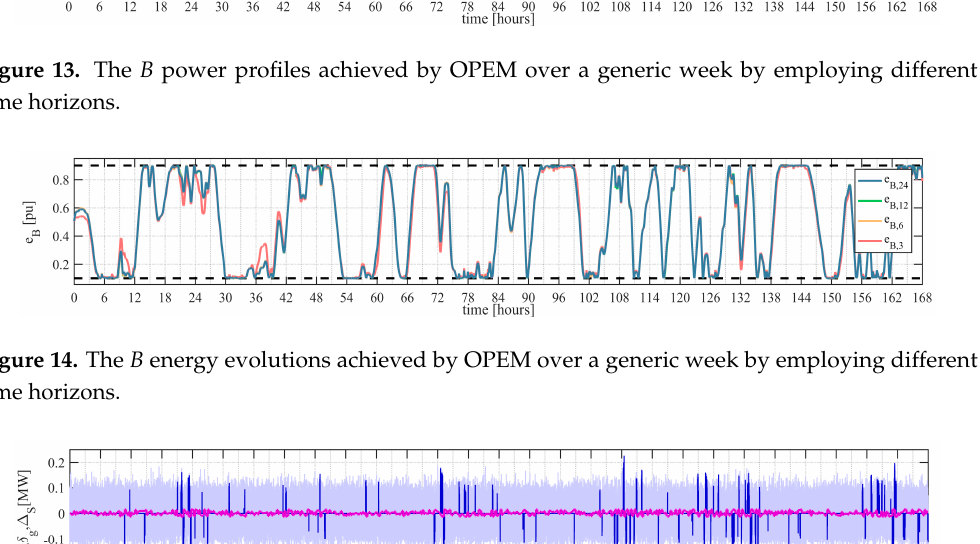
Figure 15. Power fluctuations and forecasting errors on residual power ( δ r light purple) and grid power ( δ g , blue) by employing the proposed OPEM over a generic week at T = 24 h, together with the S power demand ( Δ S , magenta). Energies 2017 , 10 , 1909